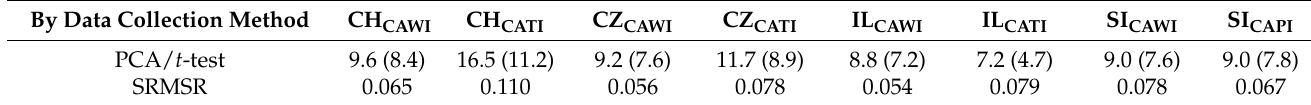
Table 8. Results of PCA/ t -test procedure (proportion of significant t -tests and lower bound of CI) and the SRMSR statistics separately for data collection method for respective